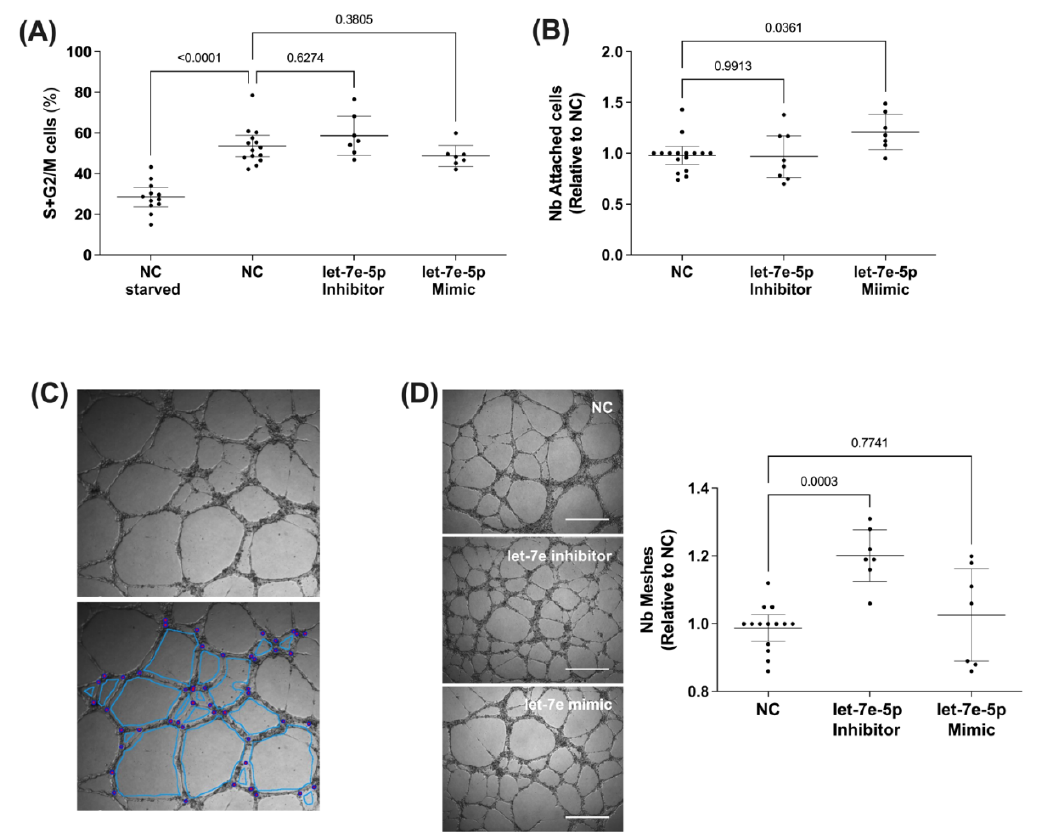
Figure 6 . Role of let-7e-5p in endothelial cell proliferation, adhesion, and tube formation. ( A ) Cell proliferation capacity of transfected HUVEC with let-7e-5p inhibitor and let-7e-5p mimic. After transfection for 18 h, cells were starved for 24 h then stimulated with complete endothelial cell media for an additional 18 h. Cells were harvested, stained with propidium iodide solution, and measured by flow cytometry. Results represent the number of cells in proliferation (interphase plus mitosis), expressed as a percentage of total cells. ( B ) After HUVEC transfection with let-7e-5p inhibitor and let-7e-5p mimic for 18 h, adhesion assays were performed as detailed in the Methods section. Data representing the number of adhered cells relative to negative control (NC) are shown as mean ± SEM ( n = 8). ( C ) Representative image of tube-formation assay (top) and the parameters analyzed (bottom). Blue/red dots represent the number of junctions, and light blue are the meshes formed by endothelial cells. ( D ) Angiogenesis capacity after HUVEC transfection with let-7e-5p inhibitor and let-7e-5p mimic. A total of 50,000 transfected cells were seeded onto Matrigel matrix and incubated for 6 h. Results represent the number of meshes formed compared to negative control (NC), expressed as mean with 95% CI. Representative images are shown on the right (original magnification ×40). Scale bar represents 500 µm. p -values were calculated using Brown Forsythe and Welch ANOVA.